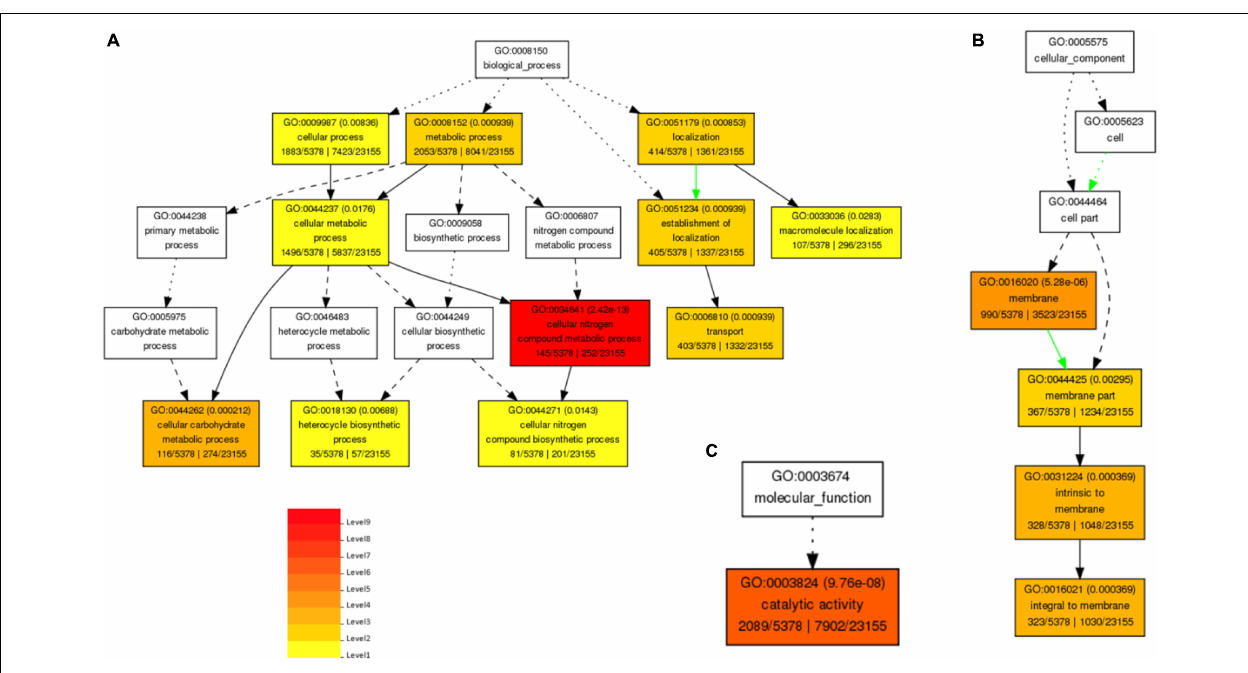
FIGURE 2 | Biological process-based GO enriched terms (A) , and Cellular component-based enriched GO terms (B) and molecular function-based Enriched GO term (C) in pearl millet seedlings under salt stress. Red to yellow colors exhibit the high to low enrichment of DETs in each GO